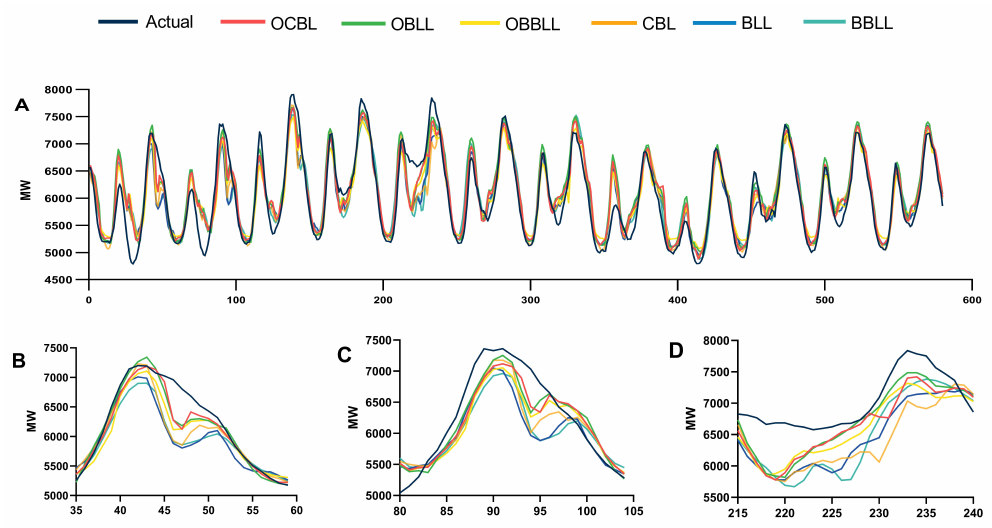
Figure 14. The prediction results and local observation for 7-step forecasting in 2019. ( A ) represents the whole prediction result. ( B – D ) describe the prediction result of different local observation